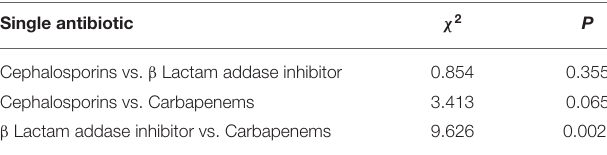
TABLE 4 | Comparison of mortality of patients with bloodstream infection treated with a common single antibiotic. Single antibiotic χ 2